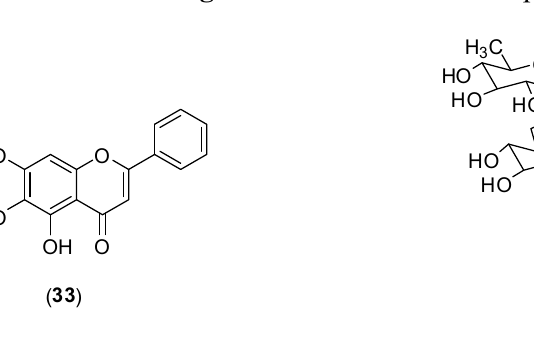
Figure 14. Structures of compounds 33 – 35